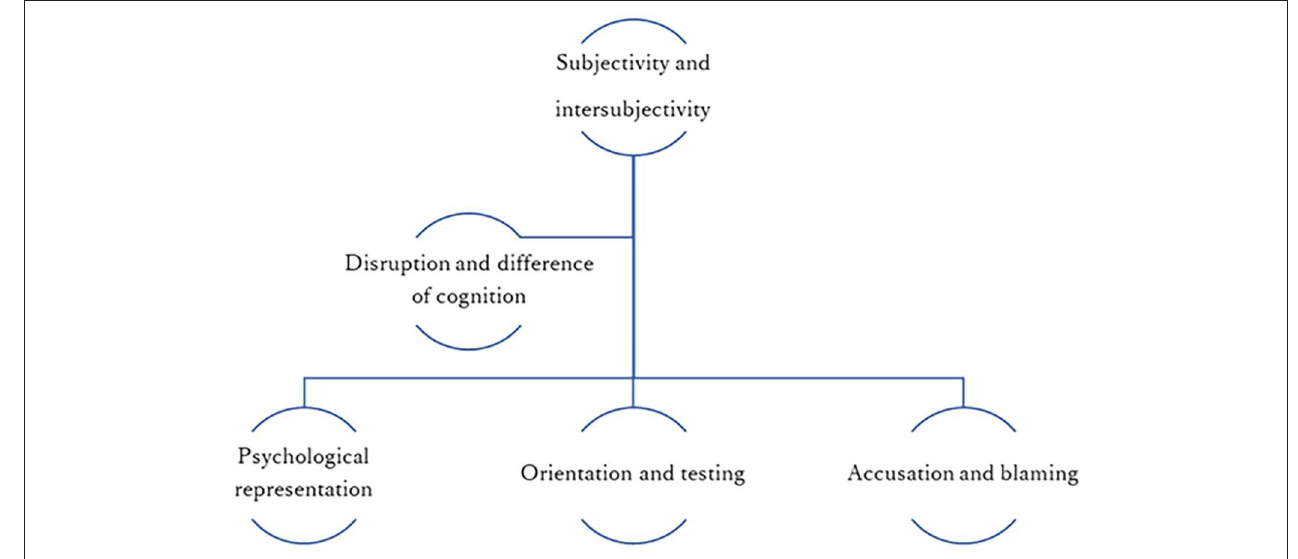
FIGURE 3 | Structure of the elements of invalidation.